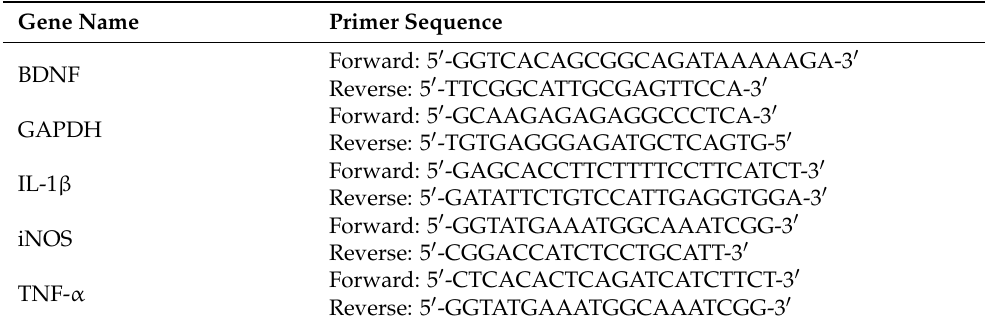
Table 1. Primer sequences used for qRT-PCR analysis